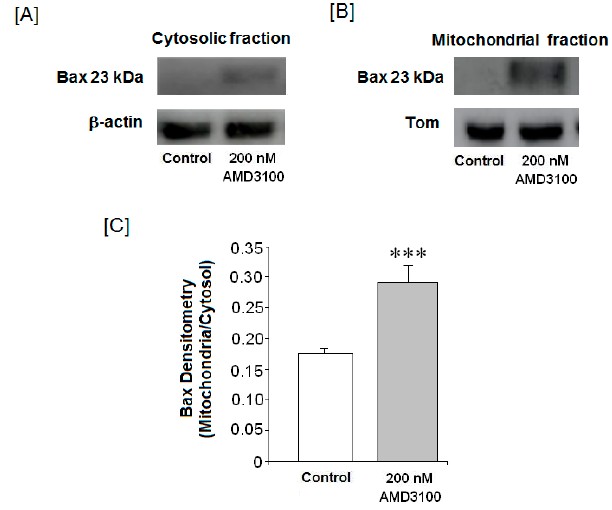
Figure 5. Effect of AMD3100 on Bax protein levels. Analysis of Bax protein levels in the ( A ) cytosol and ( B ) mitochondria by Western blot; ( C ) average of densitometry from three membranes of three different Western analyses. Results are means ± SEM from the three membranes’ densitometry. The statistical significance by t -Student test was evaluated using Sigma Plot 11 software. Differences were considered significant at p < 0.05. The asterisks indicate statistical significance as compare to control, *** p < 0.001.